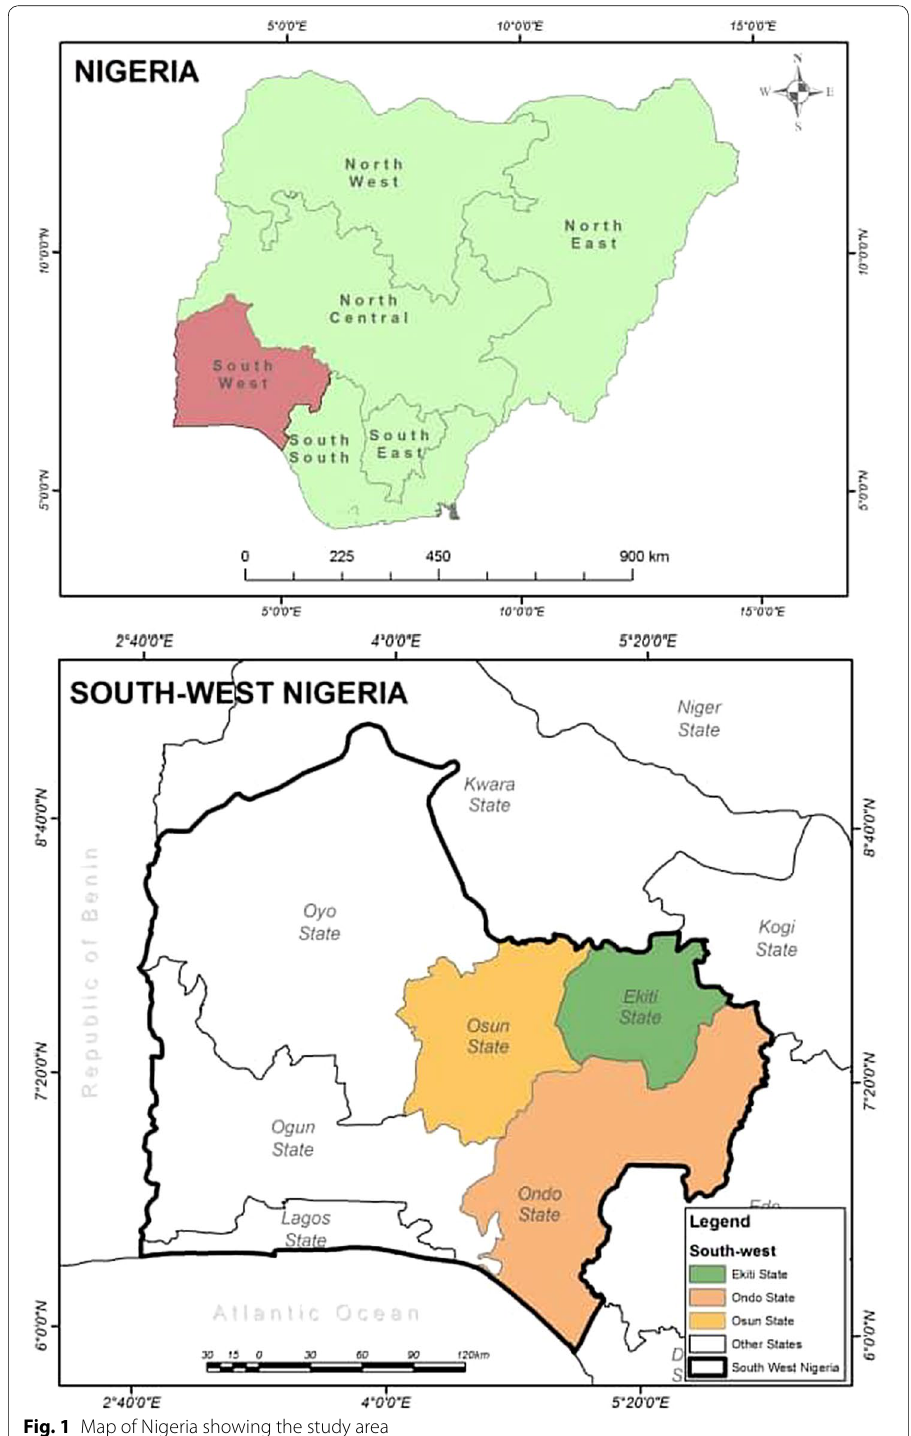
Fig. 1 Map of Nigeria showing the study